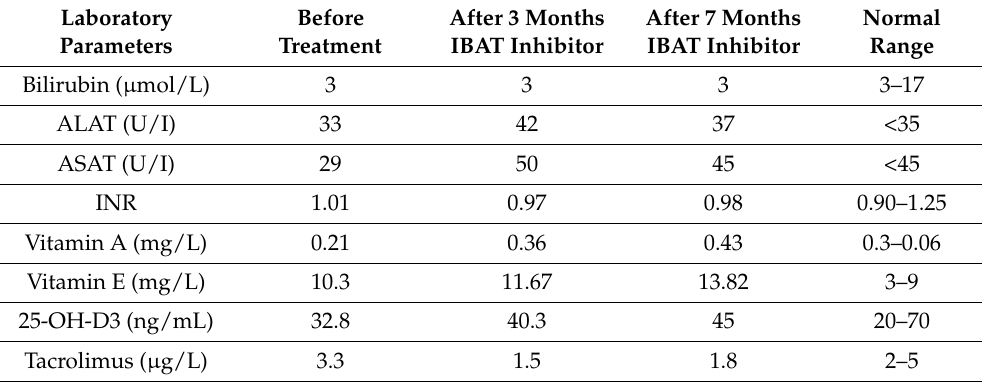
Table 1. Liver enzymes, fat-soluble vitamins before and during treatment. IBAT, ileal bile acid transporter inhibitor; ALAT, alanine aminotransferase; ASAT, aspartate aminotransferase; INR, international normalized ratio.